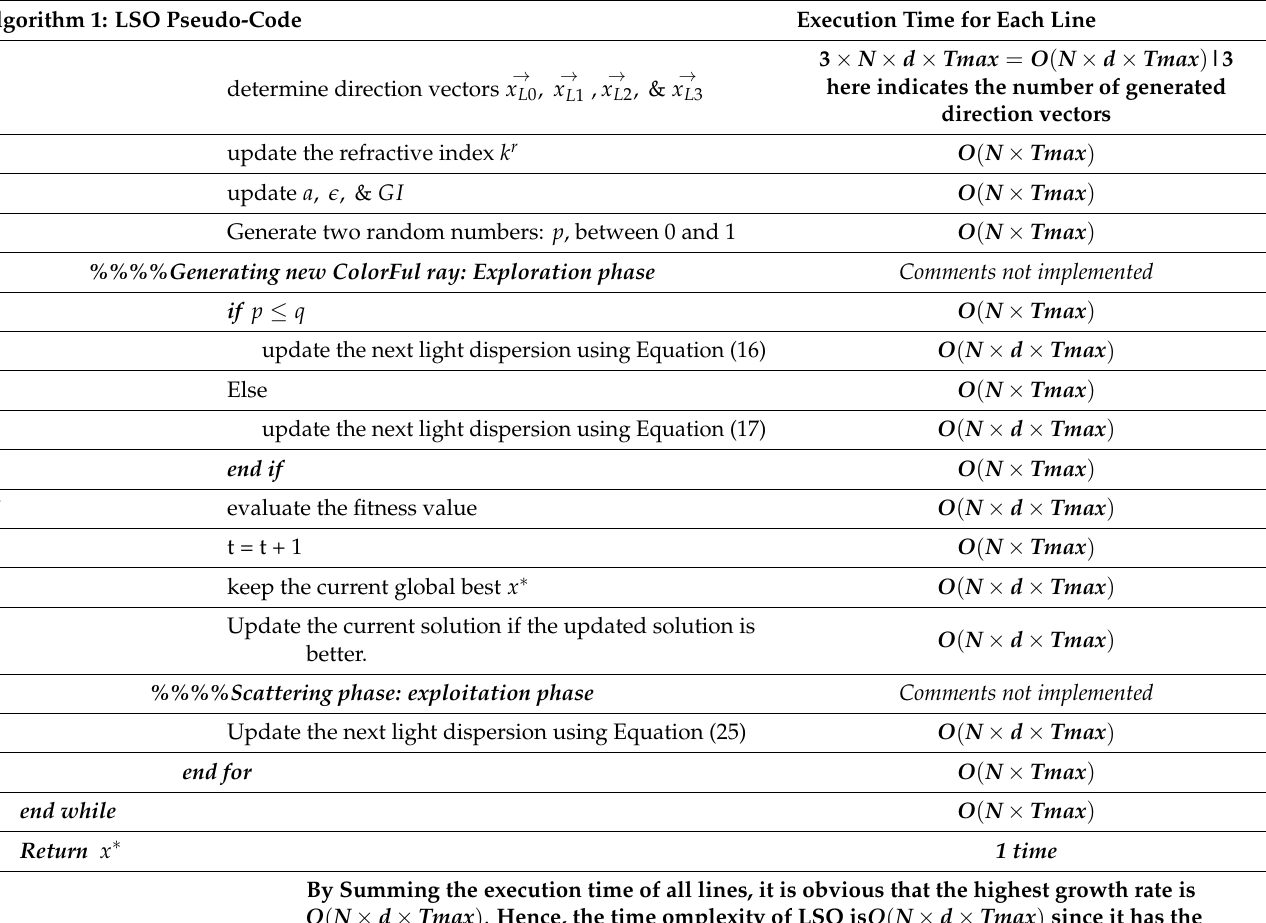
Algorithm 1: LSO